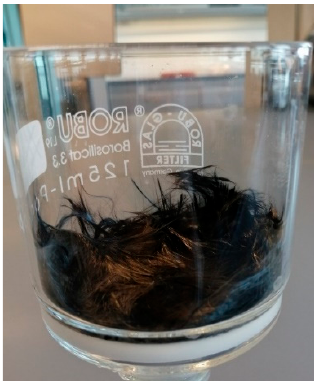
Figure 4. Remaining carbon fibers in the filter after the etching process.